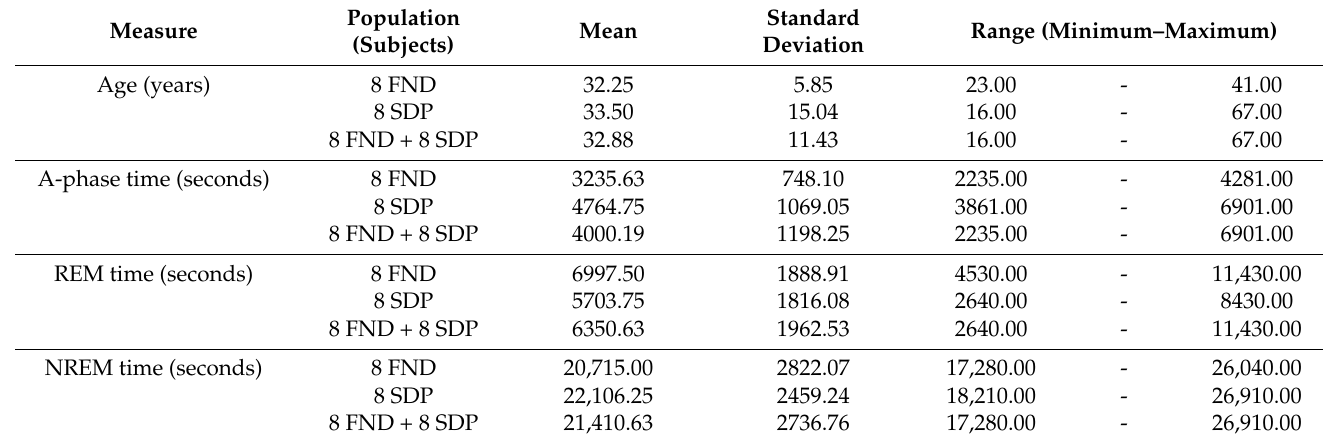
Table 1. Demographic characteristics of the studied